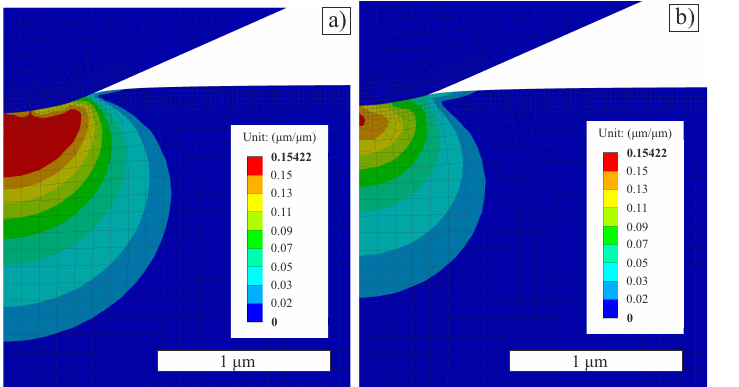
Figure 4. Equivalent von Mises strain under the tip at the end of loading a) at time = 3 s, speed = 0.67mN/s (NI) b) at time = 0.1 s, speed = 20mN/s (XPM).